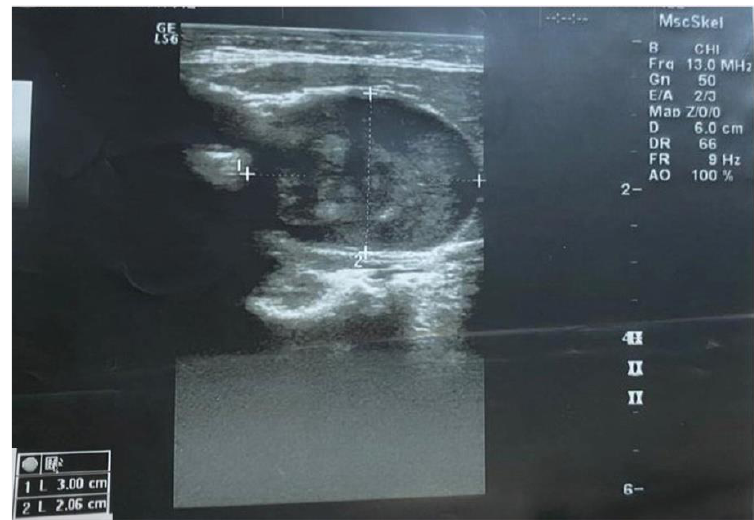
Figure 1. Ultrasound of the neck mass showing a thick-walled cyst with clear contents located on the left side, mesial to the sternocleidomastoid muscle. No flow was observed in the cyst or in the wall of the cyst upon ultrasound Doppler examination.